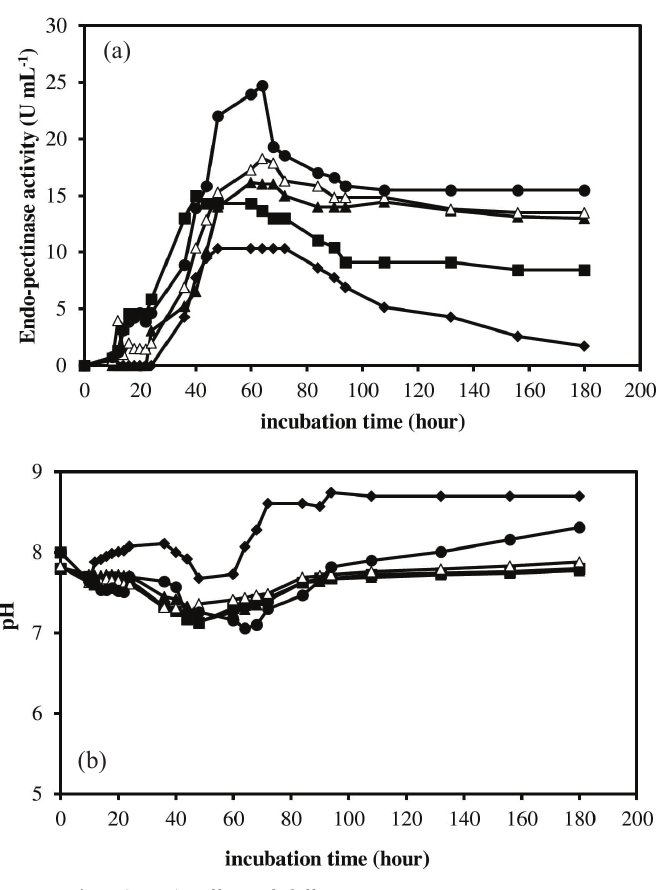
Fig. 2 – a) Effect of different pectin concentrations on en- do-pectinase production by Bacillus pumilus NRRL B-212 b) change in medium pH over time at different pectin concentra- tions (pH= 8, T: 30 °C, agitation rate: 150 rpm, ♦: 0.50 %, ■: